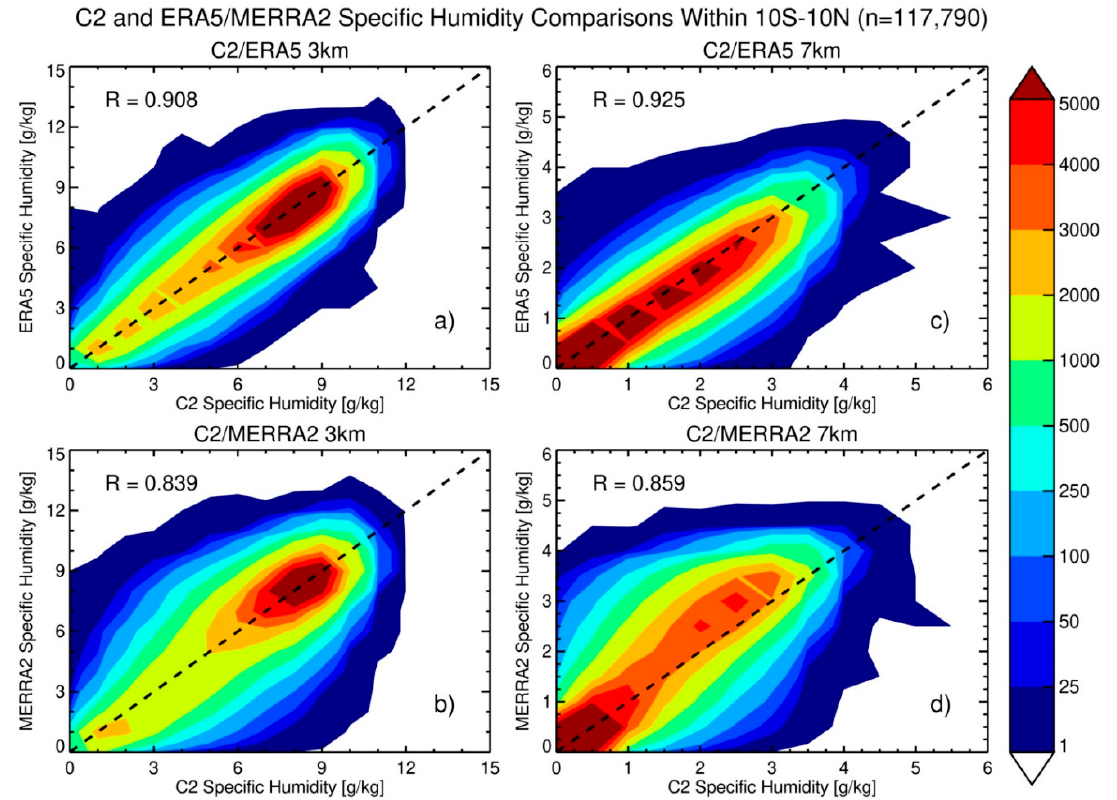
Figure 6. ( a , c ) Sampling distribution of C2 and ERA5 specific humidity (g/kg) at 3 km and 7 km, and ( b , d ) sampling distribution of C2 and MERRA-2 specific humidity (g/kg) at 3 km and 7 km within 10° N–10° S from September–December 2019. The number of collocated profile pairs is shown in the title and the correlation coefficient is also shown on each panel.